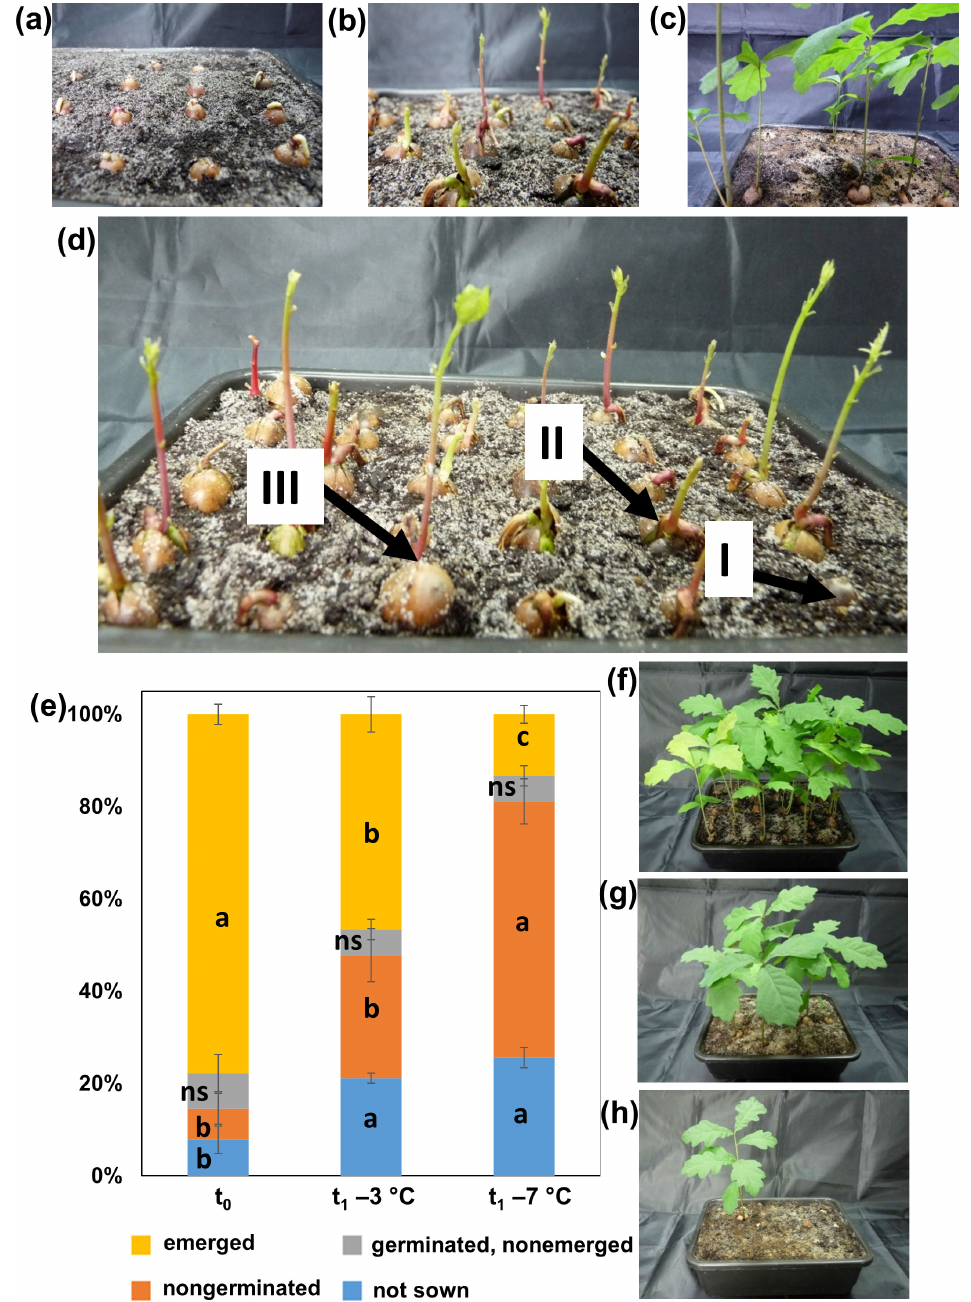
Figure 1. Germination and seedling emergence stages included one week after planting ( a ), three weeks after planting ( b ) and in 10-week-old oak seedlings ( c ). Representative image of the germination tray presenting the acorn I–III classes utilized for the seed quality study ( d ): seeds without any symptoms of germination (I), germinated seeds that developed roots but without any symptoms of shoot emergence (II) and individuals with developed roots and shoots (III). Damaged seeds were excluded from germination tests and termed ‘not sown’ acorns. Percentage distribution of the above seed classes ( e ). Data are the means of three replicates ± SE. Different letters indicate significant differences according to the HSD post hoc test. Representative trays with 10-week-old oak seedlings emerged from nonstored seeds ( f ), seeds stored at − 3 ◦ C ( g ) and seeds stored at − 7 ◦ C ( h ). ns—not